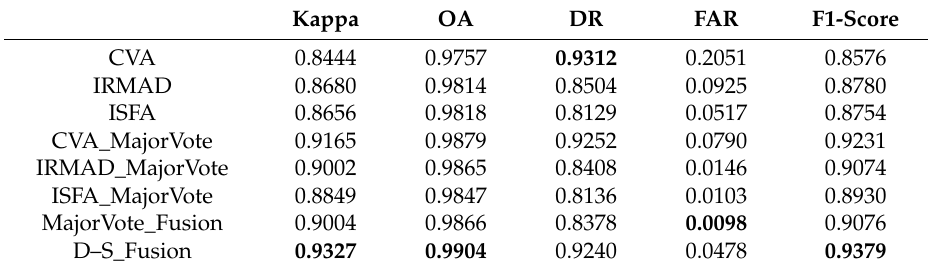
Table 2. Quantitative evaluation of the proposed method and comparative methods in test dataset 1.